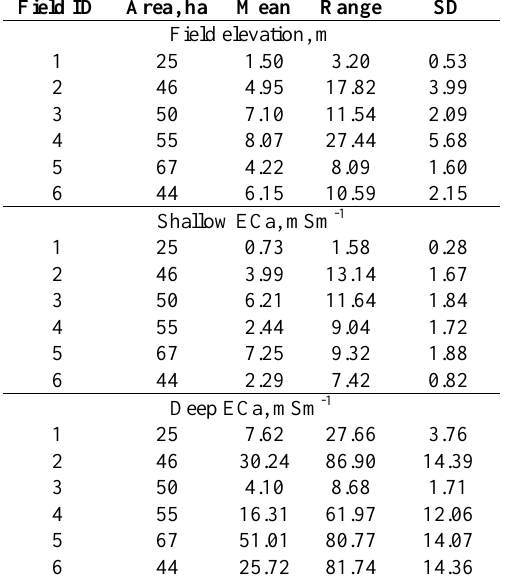
Table 1. Summary of data from agricultural fields